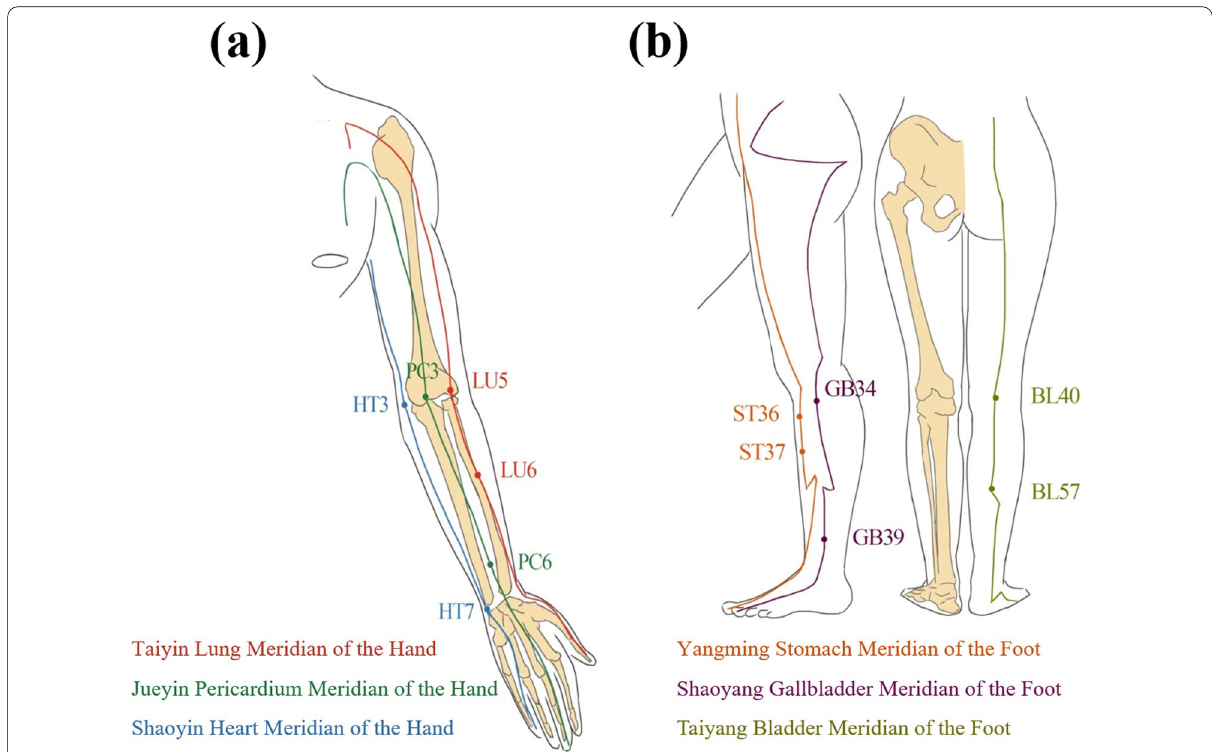
Fig. 1 Selected acupoints: a Yin meridians of the hand and b Yang meridians of the